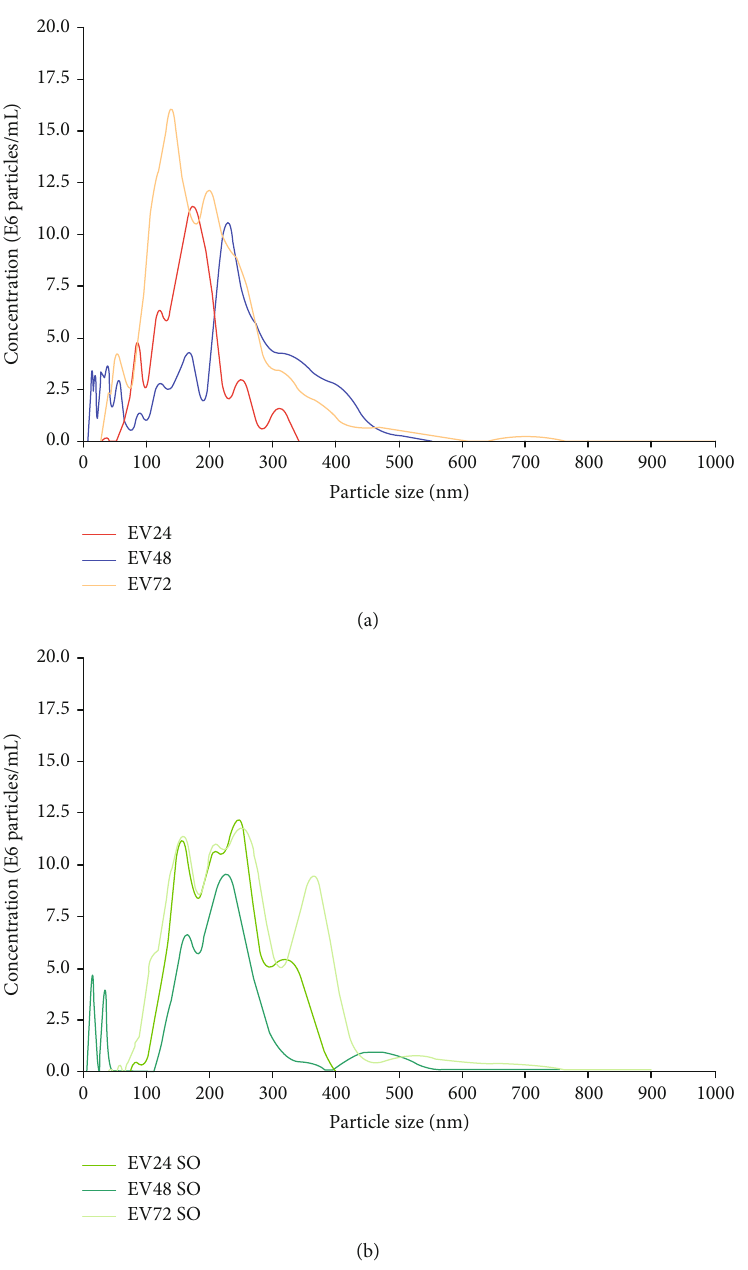
Figure 1: (a) NTA results demonstrating the particle size distribution and concentrations of EVs in each group. Peak concentrations were at particle sizes of approximately 179nm, 255 nm, and 137 nm for EV24, EV48, and EV72 groups, respectively. (b) NTA results demonstrating the particle size distribution and concentrations of EVs in each group after sonication. Peaks appear to be much less de fi ned compared to respective native